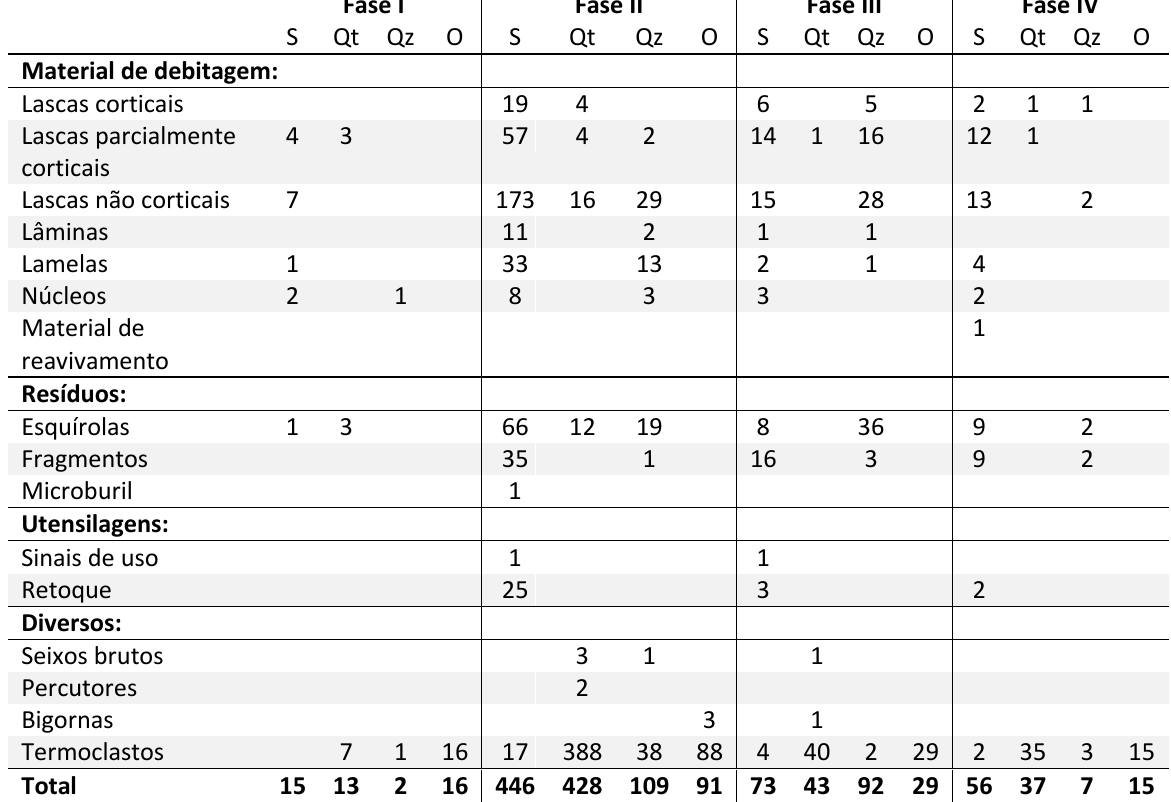
Qz - quartzo; O - outros). Table 2. Inventory of the knapped stone assemblage from Test 3, by raw material (S - flint; Qt - quartzite; Qz - quartz; O -